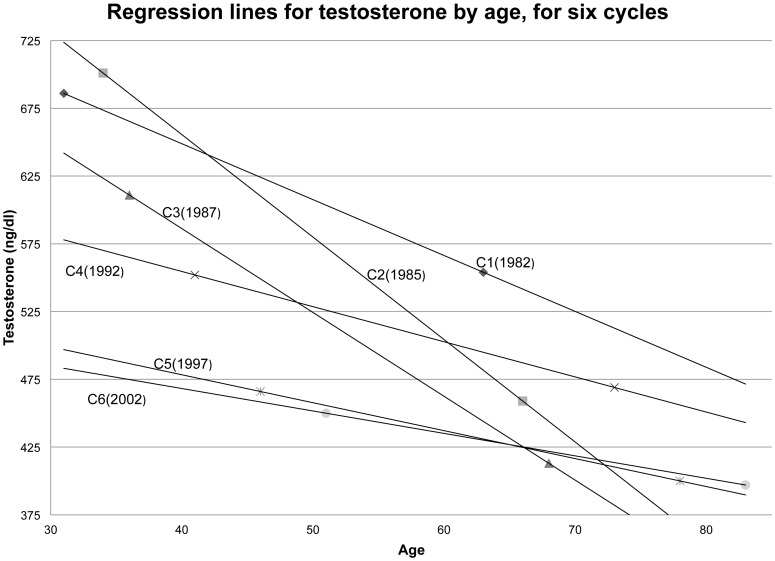
Regression lines for testosterone by age, for six cycles.